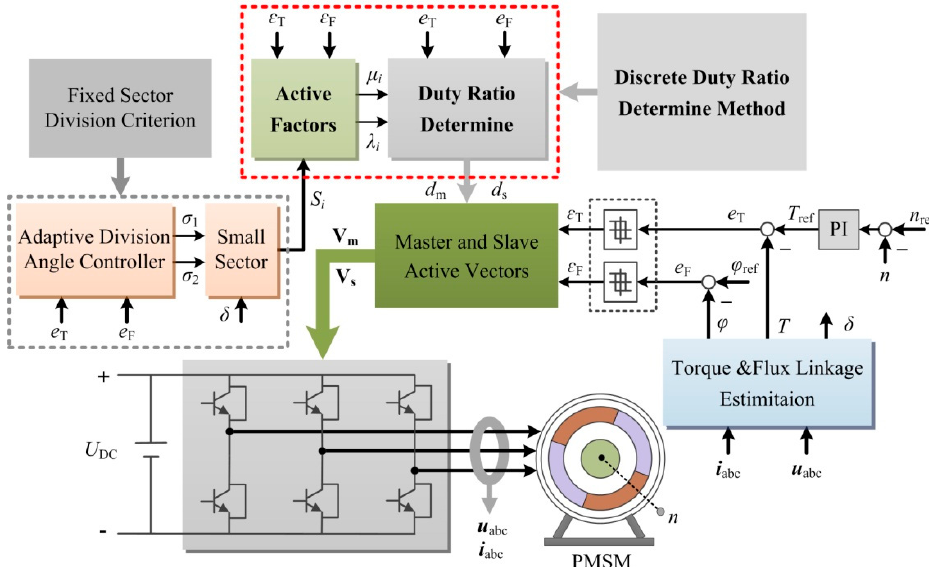
Figure 1. Schematic diagram of the discrete duty ratio determination method for novel direct torque control based on the fixed sector division criterion (FS-DDTC) for a permanent magnet synchronous motor (PMSM).